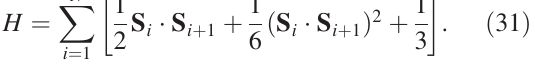
FIG. 4. Energy difference with the exact ground-state energy of a spin-1 extension of a RBM [Eq. (27)] with D ¼ 2 and different number of strings for the AKLT model on a spin-1 chain with eight spins. A nonlocal SBS with noncommuting matrices and one string is exact within numerical